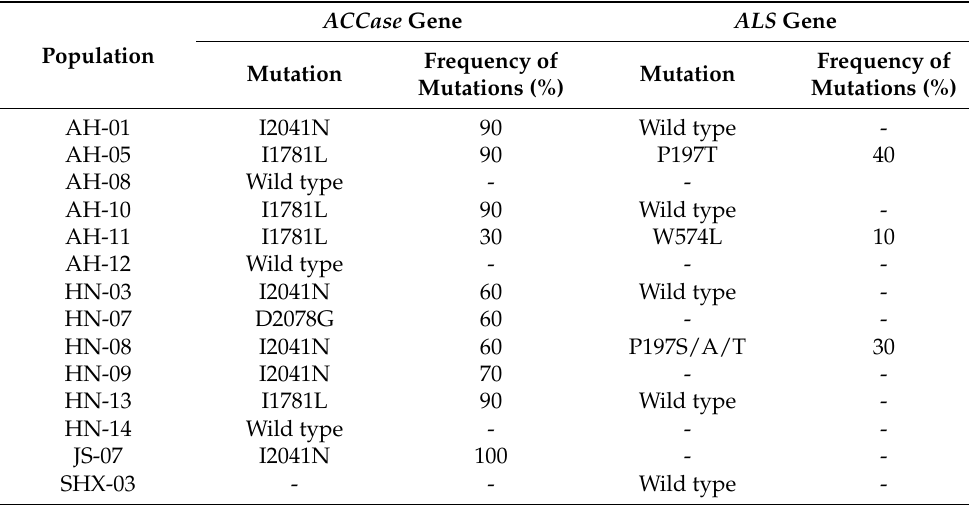
Table 6. Mutations and their frequencies in different L. multiflorum